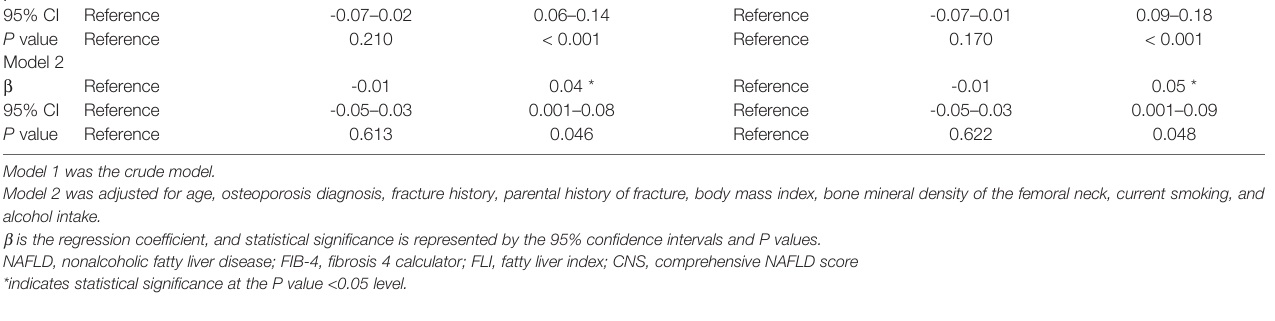
TABLE 4 | Association of NAFLD with FIB-4 de fi ned liver fi brosis and 10-year major osteoporotic fracture probability in Korean men with sarcopenia aged ≥ 50 years. NAFLD by FLI NAFLD (-)Fibrosis (-)